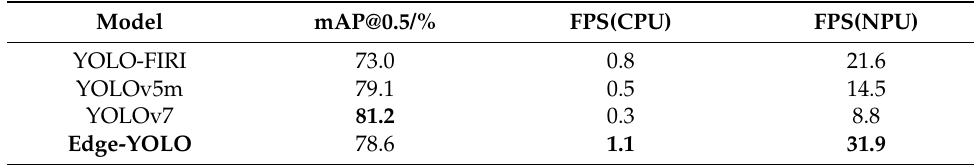
Table 4. Testing results on the RK3588 platform.